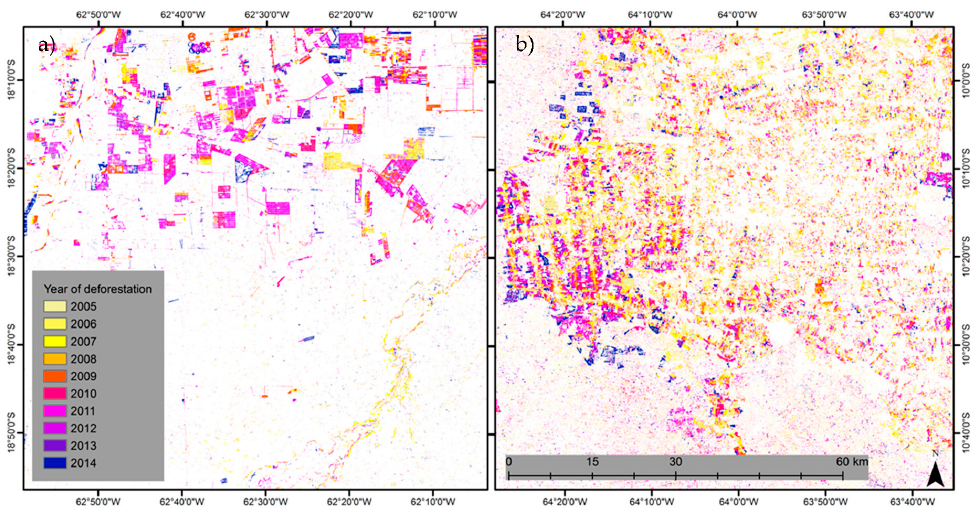
Figure 10. The year in which deforestation events detected from Landsat time series at Bolivian site ( a ) and Brazilian site ( b ) over the period of 2005–2014 occurred. Deforestation was detected as an extreme event in Landsat data cube with a reference period containing one-year of data.